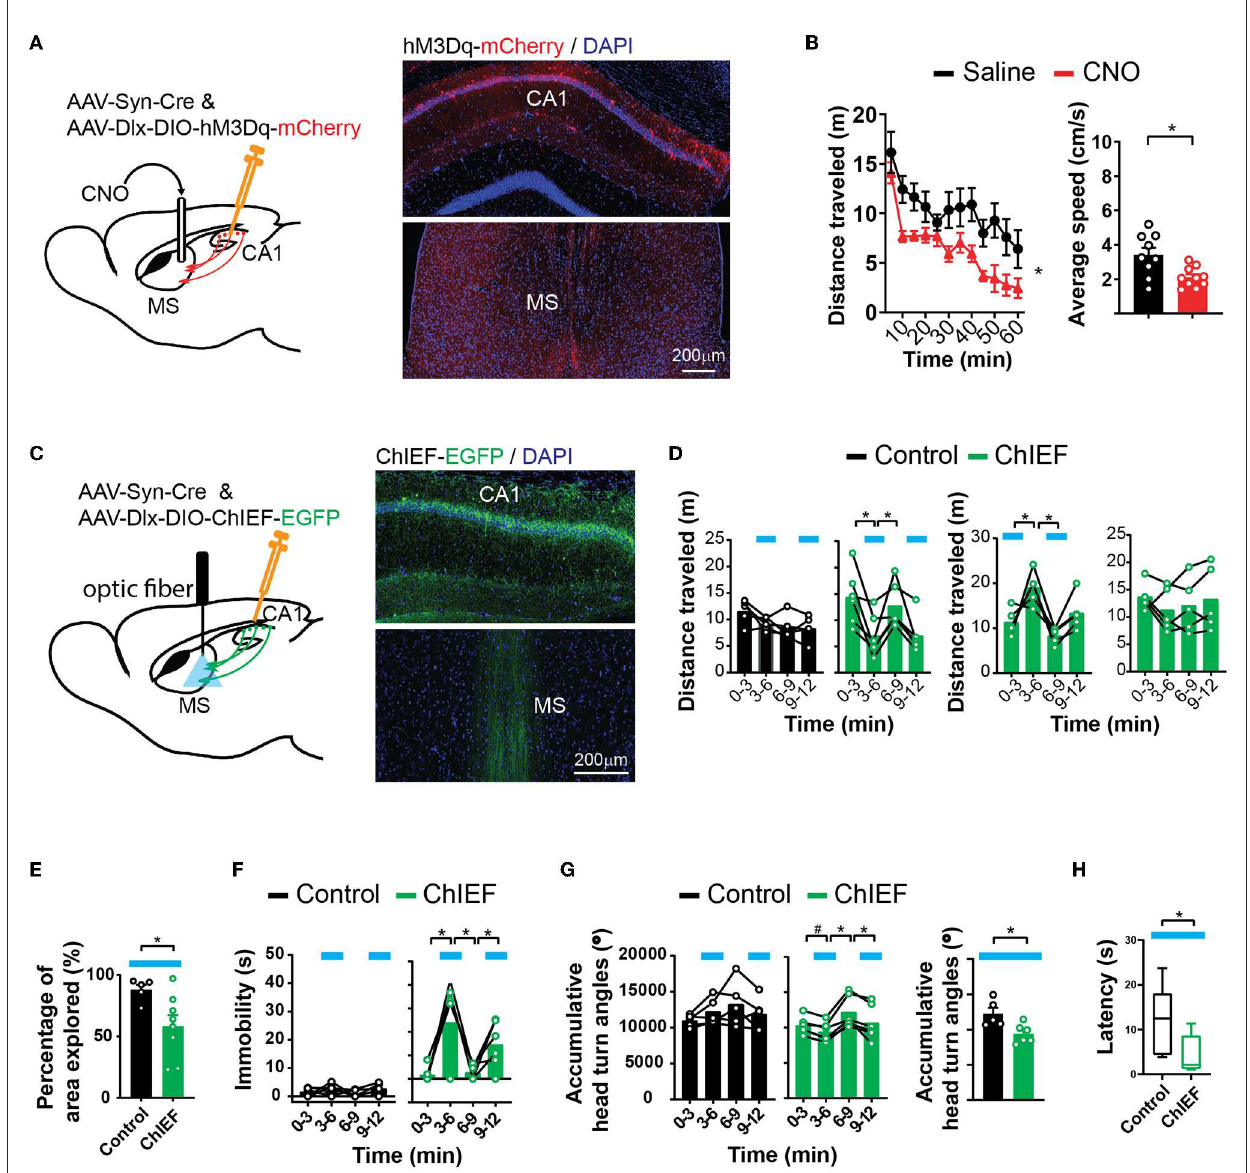
FIGURE4 Activation of hippocampal inhibitory projections to the MS reduces locomotion. (A) Pharmacogenetic activation of the hippocampal inhibitory inputs to the MS with local infusion of CNO in the MS. (B) CNO decreased locomotion in the open field as measured by distance traveled [two-way ANOVA, F (1,17) = 9.00, * p < 0.05] and average speed (two-tailed t -test, * p < 0.05) (saline, n = 9 mice; CNO, n = 10 mice). (C) Optogenetic activation of the hippocampal inhibitory inputs to the MS by light. An excitatory channelrhodopsin, ChIEF, was expressed in the hippocampal GABAergic neurons with AAVs in the “ChIEF” mice. Control mice received AAVs expressing EGFP only. (D–H) Light delivered to the MS (indicated by blue bars) decreased mouse locomotion measured by distance traveled (D) , percentage of the open-field area the mice explored (E) , immobility (F) , accumulative angles of head turns (G) , and latency to reach a low speed (H) . [ (D) Two-way ANOVA. Left ChIEF group, light, F (1,5) = 30.42, p < 0.05; Right ChIEF group, light, F (1,4) = 10.15, p < 0.05; Tukey’s multiple comparison test, * p < 0.05. (E) Two-tailed t -test, * p < 0.05. (F) Left two-way ANOVA. Control group, light, F (1,4) = 5.409, p = 0.08; ChIEF group, light, F (1,5) = 10.57, p < 0.05; Tukey’s multiple comparison test, * p < 0.05. (G) Left two-way ANOVA. Control group, Light, F (1,4) = 0.03, p = 0.86; ChIEF group, light, F (1,5) = 22.01, p < 0.05; Tukey’s multiple comparison test, * p < 0.05; Right